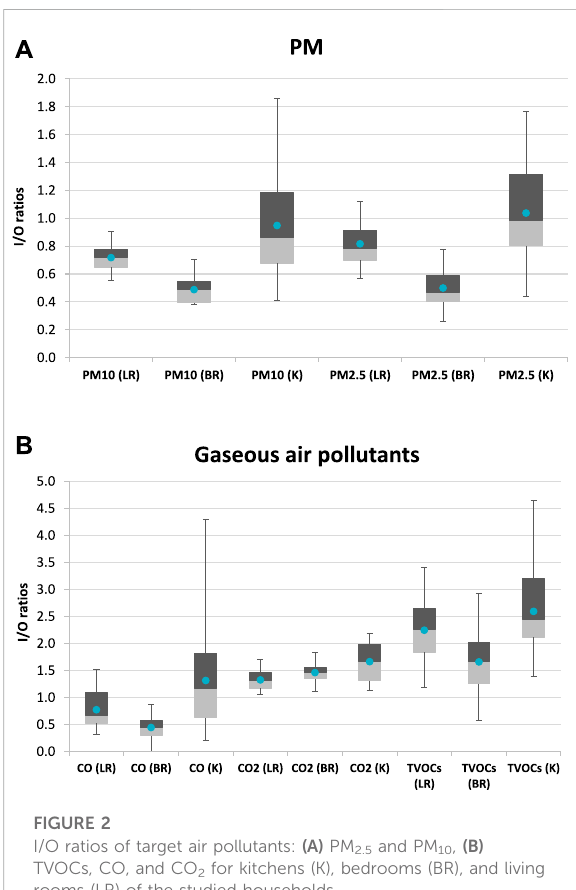
FIGURE 2 I/O ratios of target air pollutants: (A) PM 2.5 and PM 10 , (B) TVOCs, CO, and CO 2 for kitchens (K), bedrooms (BR), and living rooms (LR) of the studied